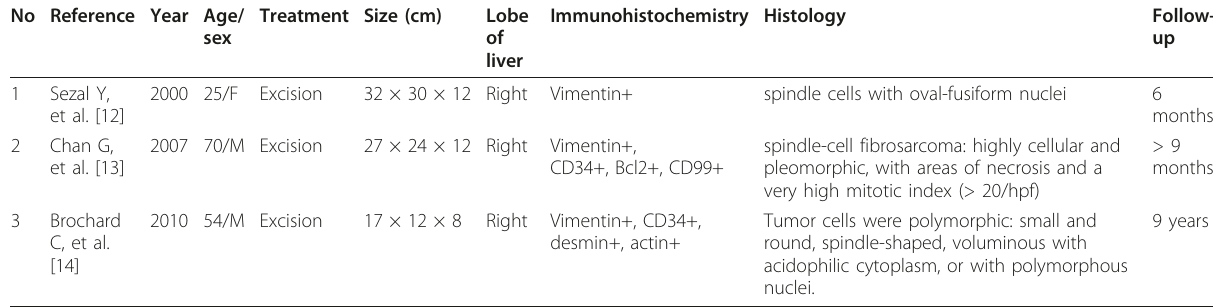
Table 1 Clinicopathological features of the reported malignant cases of liver solitary fibrous tumors No Reference Year Age/ Treatment Size (cm) Lobe sex of